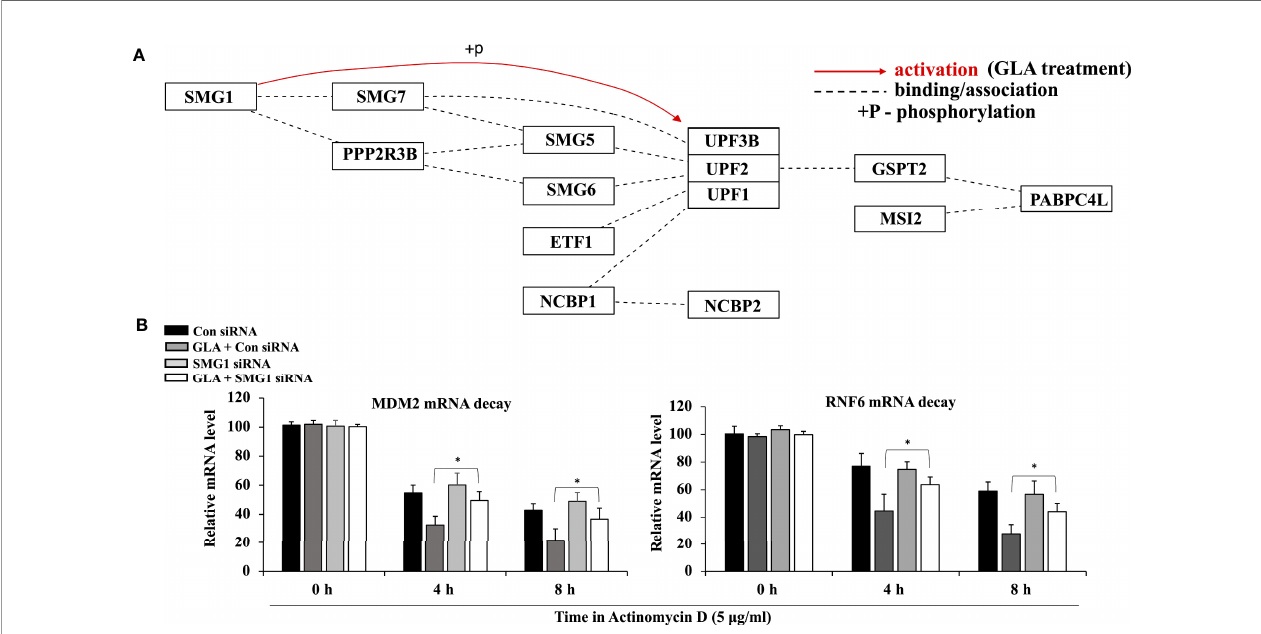
FIGURE 5 | Activation of the SMG1-UPF mRNA decay mechanism by GLA contributes to the downregulation of MDM2 and RNF6 in GC cells. (A) Pathway analysis of SMG1-UPF in GC cells in the presence of GLA. (B) The stability of MDM2 and RNF6 mRNA at 0 h, 4 h, and 8 h in HGT-1 and SNU-1 cells with SMG1 siRNA transfection after treatment with 5 µg/ml of actinomycin D and 10 µM of GLA. The data represented the mean ± SD (n=3). * p <